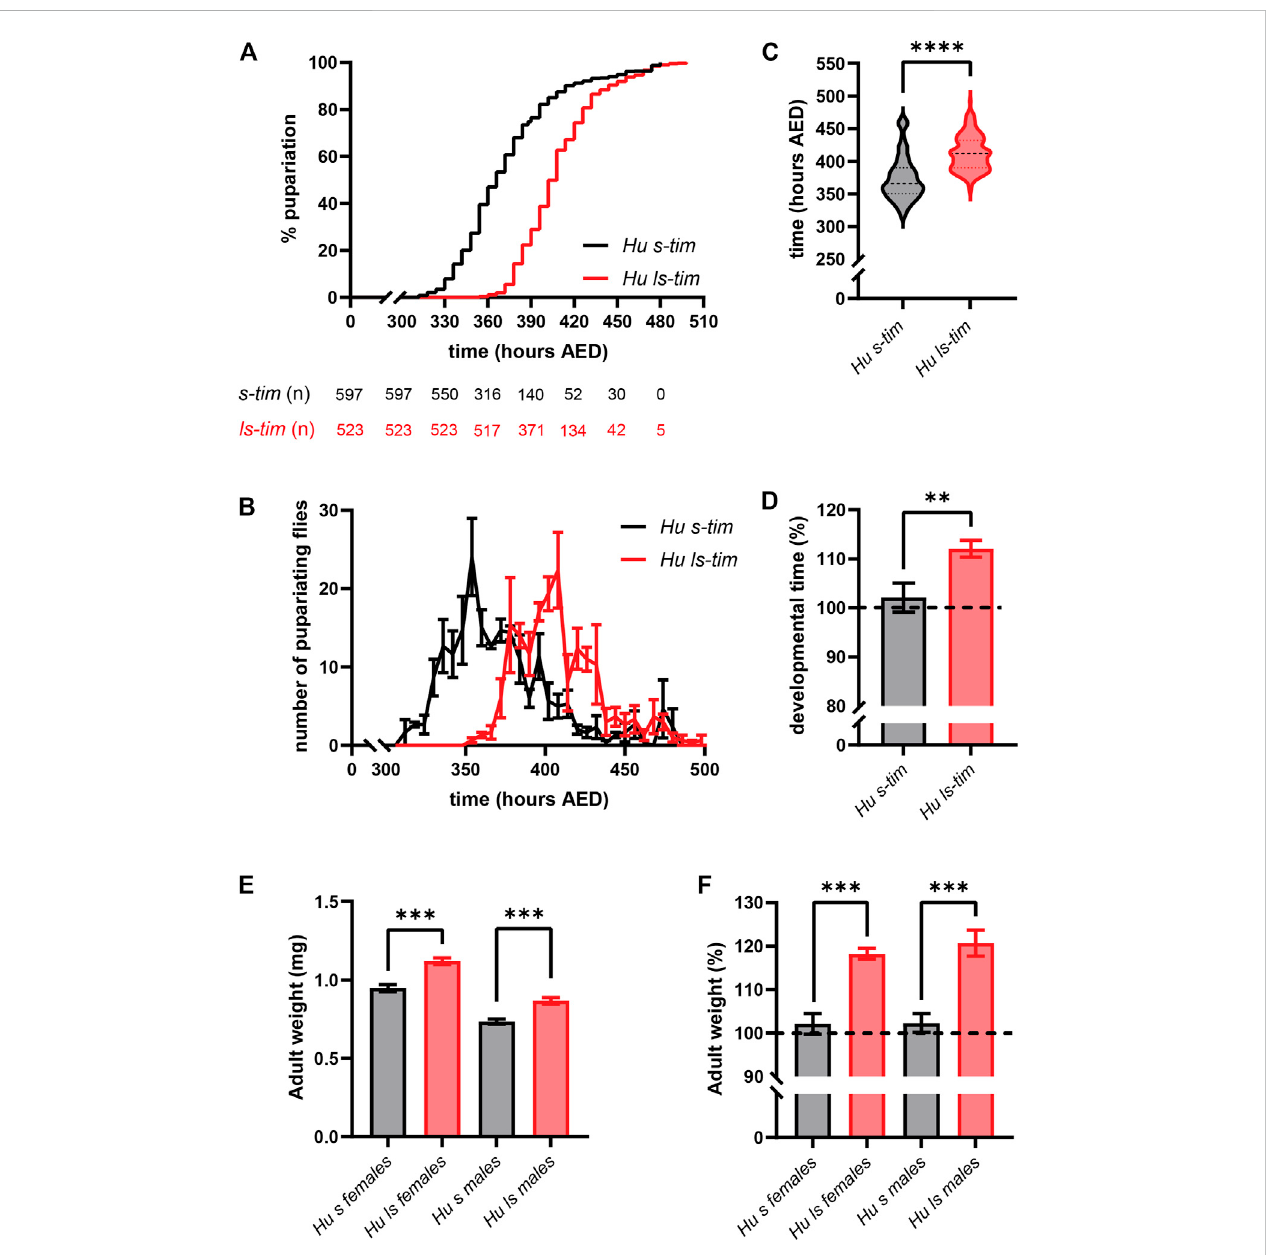
Differences in developmental time between s-tim and ls-tim homozygous fl ies increase at lower temperature and lead to changes in the size of emerging fl ies. (A) Pupariationcurvesof s-tim (black)and ls-tim (red)homozygouslarvaepupariatingovertimeat15 ° C(LD12:12).Thetimespanningbetween egg deposition and pupariation was de fi ned as developmental time. Log-rank (Mantel-Cox) test, p < 0.0001. AED: After Eggs Deposition. The number of residual,non-pupariatedlarvaefromeachgenotypeatdifferenttimepointsisreportedbelowthegraph. (B) Averagenumber(±SEM)ofpupariating s-tim and ls-tim homozygous larvae at 15 ° C over time. (C) Egg-to-adult developmental time of s-tim and ls-tim homozygous fl ies at 15 ° C. Statistical analysis of developmentaltime(hoursaftereggdeposition,AED)wasperformedbyMann-WhitneyUtest,**** p < 0.0001. (D) %increaseinthedevelopmentaltimeof ls- tim fl iesat 15 ° C comparedto s-tim individualsused as reference(t test, df = 4, ** p < 0.01. (E) Adult weight of s-tim and ls-tim homozygous males and females emerging in a 24 h window. For every biological replicate, fl ies were weighted in batches of 10, and the average weight (±SD) of each fl y determined and plotted. Statistical analysis was performed by t test, df = 4, *** p < 0.001. (F) Increase in adult weight in ls-tim homozygous males and females expressed as % (±SD) of the weight of their s-tim counterparts. Statistical analysis was performed by t test, ***, df = 4, p <